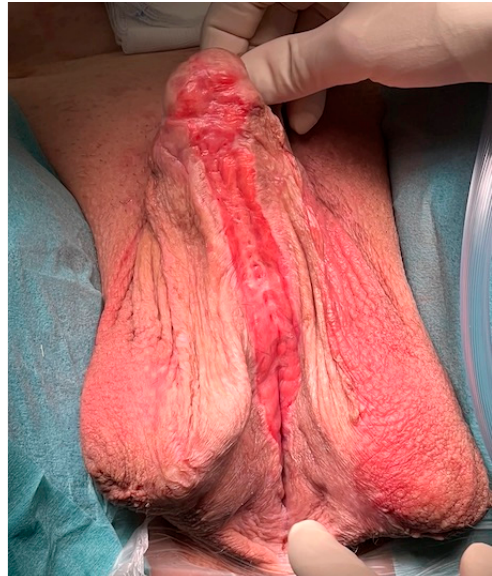
Figure 7. Completely healed skin transplant ensuring optimal conditions for the reconstruction of the neourethra.